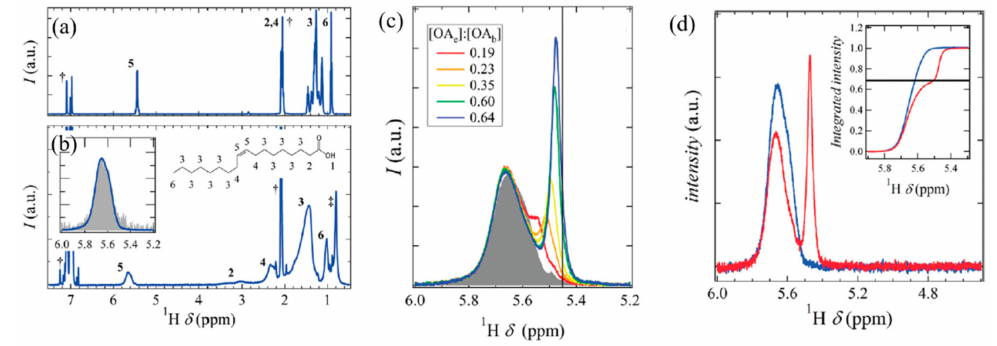
Figure 4. 1 H NMR spectrum of ( a ) free-state OA and ( b ) OA-capped CdSe QDs. Change in alkene resonance upon addition of ( c ) free OA and ( d ) deuterated OA. Reprinted with permission from [59]. Copyright 2012, American Chemical